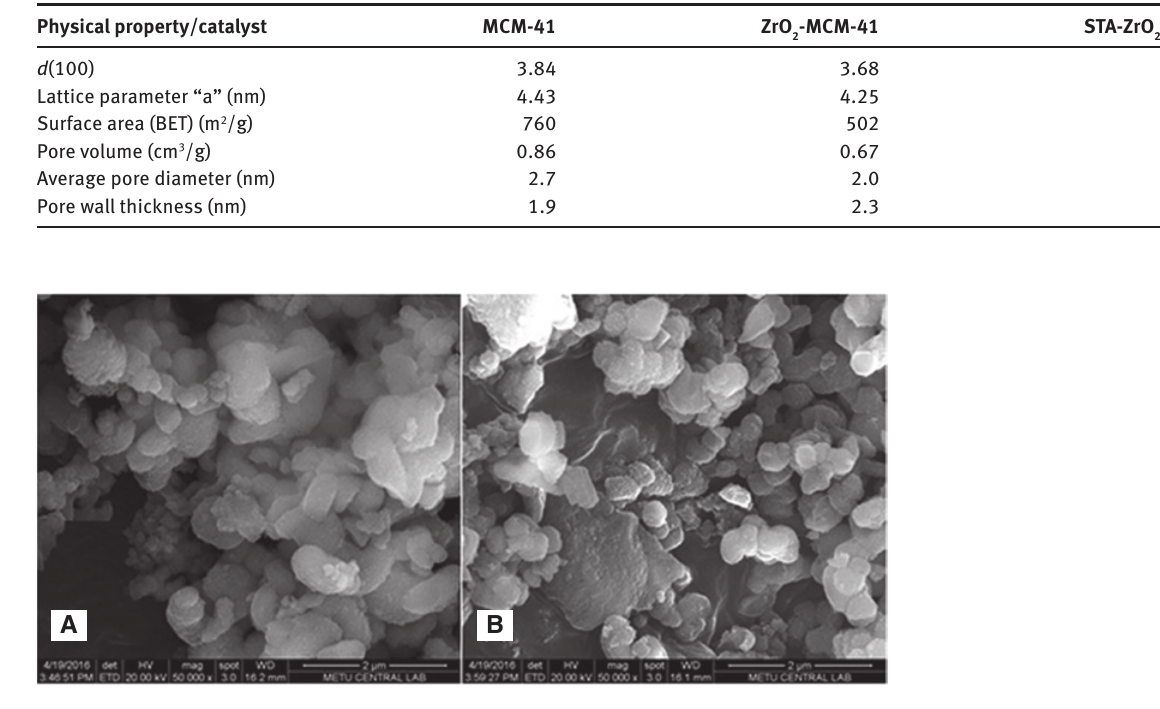
-MCM-41, (B) STA-ZrO 2